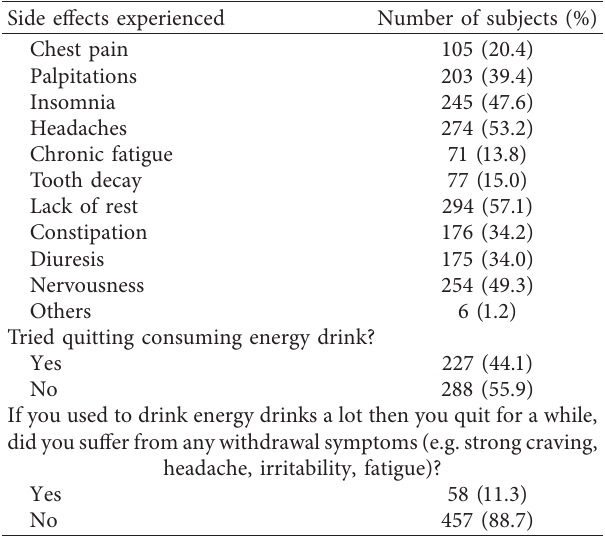
Table 5: Evaluation on the adverse effects experienced from ED consumption, attempt to quit ED, and withdrawal symptoms ex- perienced in the attempt to quit